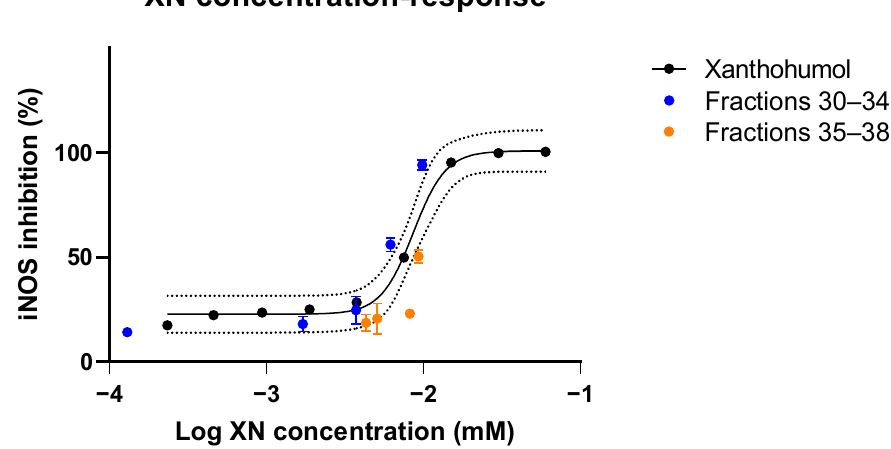
Figure 8. Concentration-response curve of iNOS inhibition by pure xanthohumol (black) and hops extract fractions 30–38. The dotted lines represent 95% prediction bands.